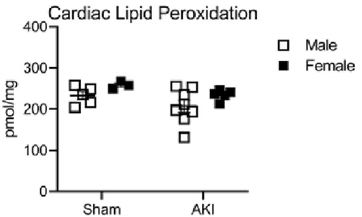
Figure 7. Cardiac lipid peroxidation in males and females 1 year after AKI or sham procedure. In the heart, there was no difference in lipid peroxidation with respect to either sex or AKI. (n = 5–7).